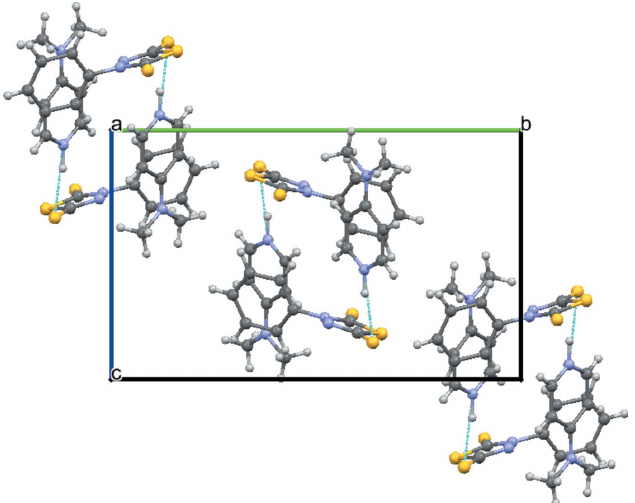
Figure 4 Packing diagram of compound (I) viewed down the a -axis. Hydrogen bonds are shown as dashed lines.